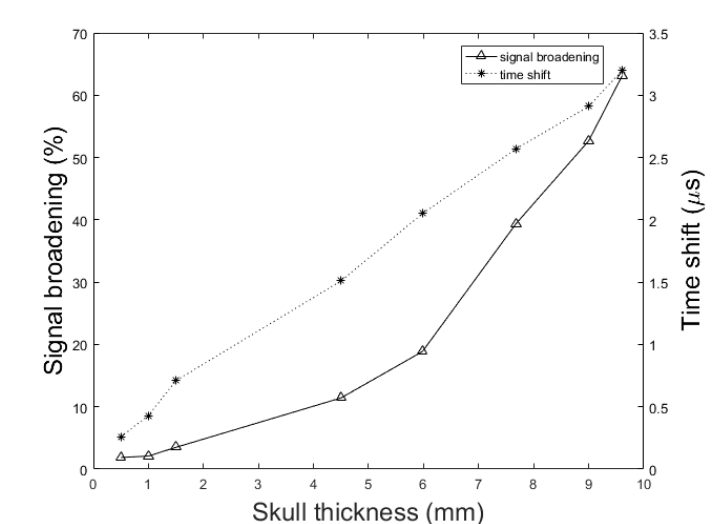
Figure 10. Simulation results of the effect of skull thickness on the signal broadening (solid line) and time shift (dotted line) of transcranially recorded signal relative to the undisturbed signal.